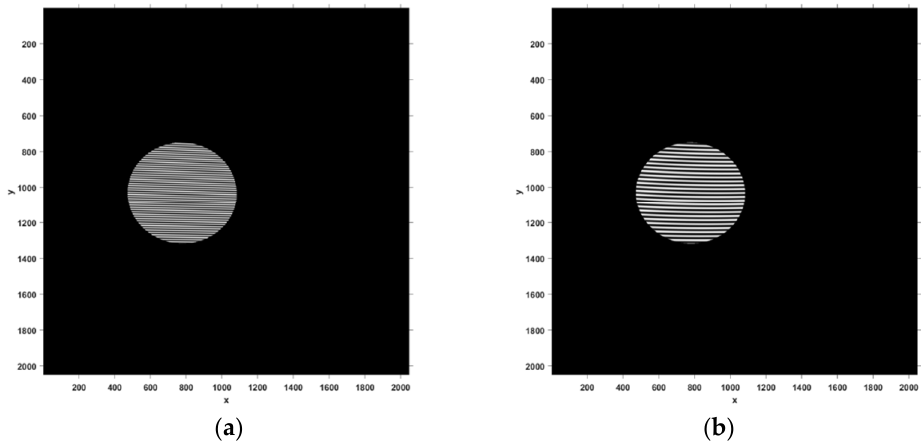
Figure 5. One of the simulated fringe patterns in camera view for planar mirror and concave mirror. ( a ) The deformed horizontal fringe pattern image simulated for planar mirror. The resolution is 2048 × 2048 pixels; the sinusoidal fringe initial phase is 0, and the period is 8 screen pixels. ( b ) The deformed horizontal fringe pattern simulated for the 200 mm-focus concave mirror; its initial phase is 0, and the period of fringe patterns is 8 pixels.